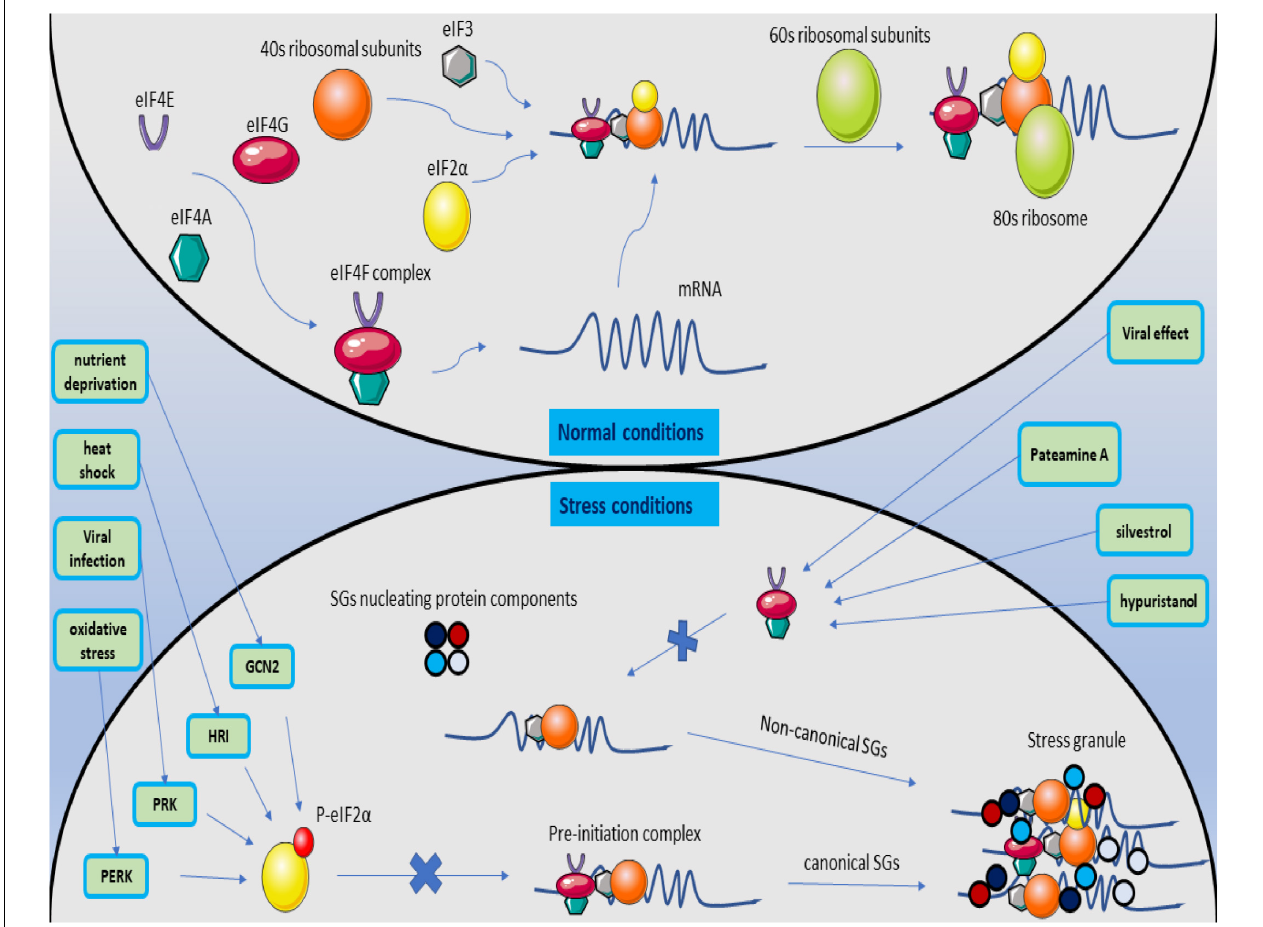
FIGURE 5 | Magnification of canonical and non-canonical stress granules. Under normal conditions, the translation process begins with forming the eIF4F structure and identifying the 5 (cid:48) cap structure on the mRNA. The pre-initiation complex is formed by joining eIF3, the ribosomal 40S subunit, and non-phosphorylated eIF2a with the initial tRNA. Then, with the 60S ribosome subunit, the ribosome structure is completed, and the translation process is followed. When the cell is stressed, it activates PERK, PRK, HRI, and GCN2 kinases, causes phosphorylation of eIF2a, and prevents the binding of P-eIF2a to the PIC structure. The exact process creates the structure of canonical SGs. If the stress on the cell proceeds by inhibiting the formation of the eIF4F structure by affecting its subunits, the formation of non-canonical SGs is followed by merging the SGs nucleating protein components in the eIF2a independent